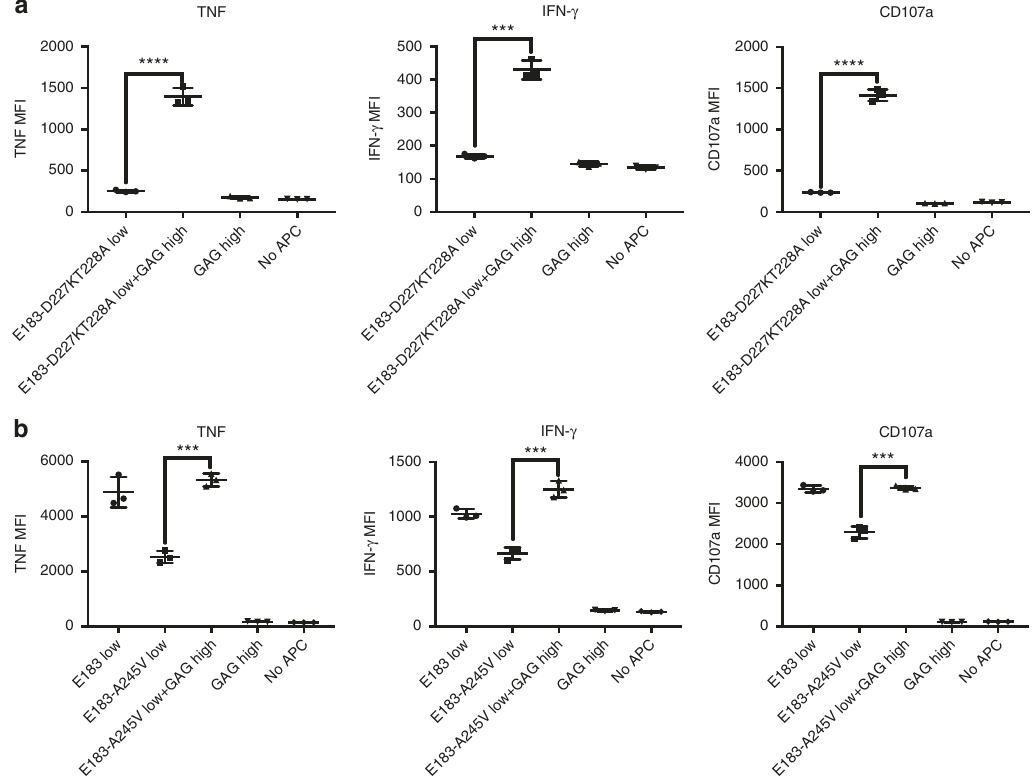
Fig. 5 Nonstimulatory pMHC can enhance T-cell activation when CD8 binding to antigenic pMHCI is abrogated. sc GAG-HLA-A2 constructs were transfected into the T-REx CHO clone that could express low amount sc E183-HLA-A2 bearing D227K,T228A ( a ) or A245V ( b ) mutation. Single cell clones were sorted. Indicated T-REx CHO clones were co-cultured with human E183 CTL for 3 h. Cytokine production (TNF and IFN- γ ) and upregulation of the degranulation marker CD107a were assessed by antibody staining and fl ow cytometry. Statistical signi fi cance was determined by using unpaired two-sided Student ’ s t test and shown as mean ± s.d. (ns nonsigni fi cant, * p < 0.05, ** p < 0.01, *** p < 0.001, **** p < 0.0001). Data are representative of three independent experiments. MFI mean fl uorescence